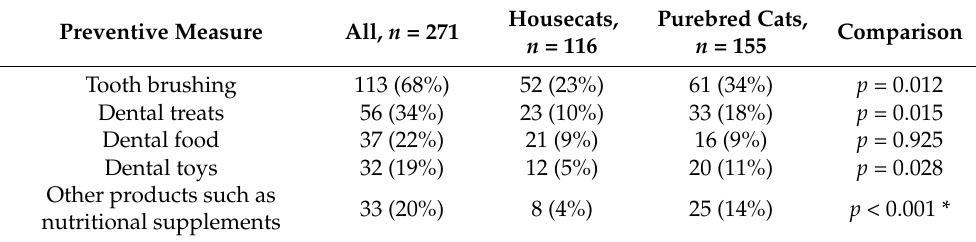
Table 4. Owner reported preventive measures on dental health in their cats. In total, 167 cat owners reported on 271 preventive measures they perform. The p -value for statistical significance was adjusted using the Bonferroni correction to avoid incorrect significance testing results due to multiple testing ( p -value for statistical significance = 0.05/5 = 0.01). * indicates statistical significance.